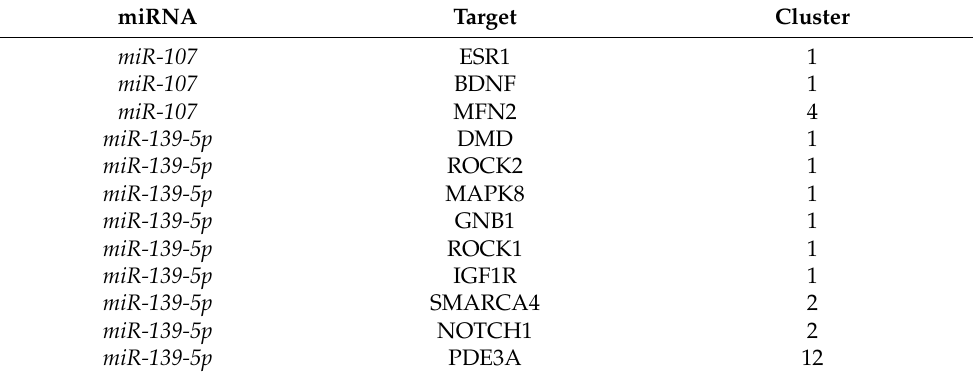
Table 3. Clustered miRNA targets detected in the STRING-generated heart failure database. miRNA Target Cluster miR-107